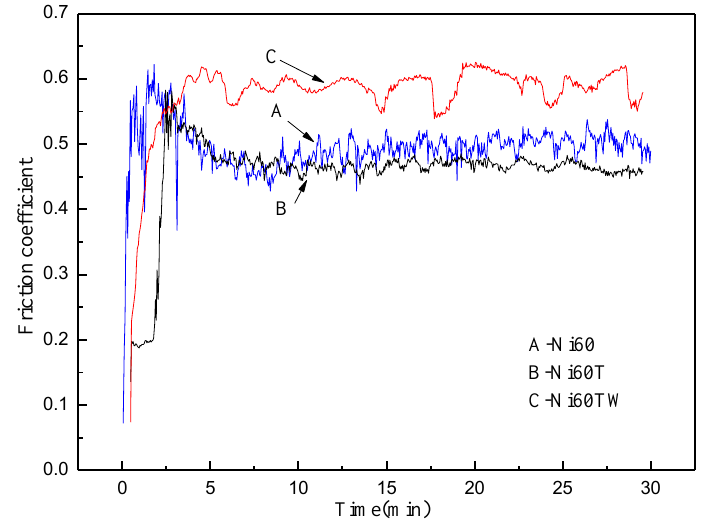
Figure 7. Friction coefficient of composite ceramic coatings.